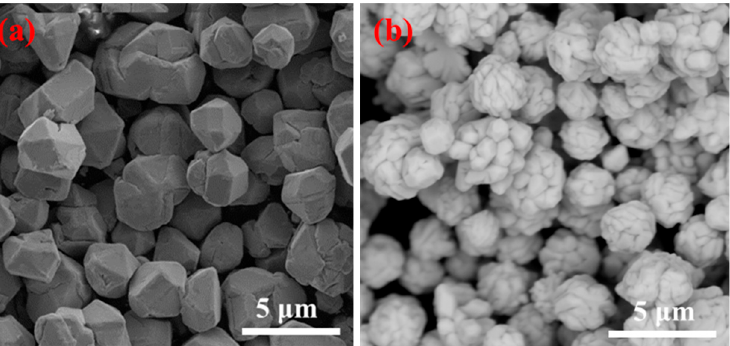
Figure 4. SEM of silver particles prepared by the conventional drop-in method. ( a ) Conventional method and ( b ) microjet method.